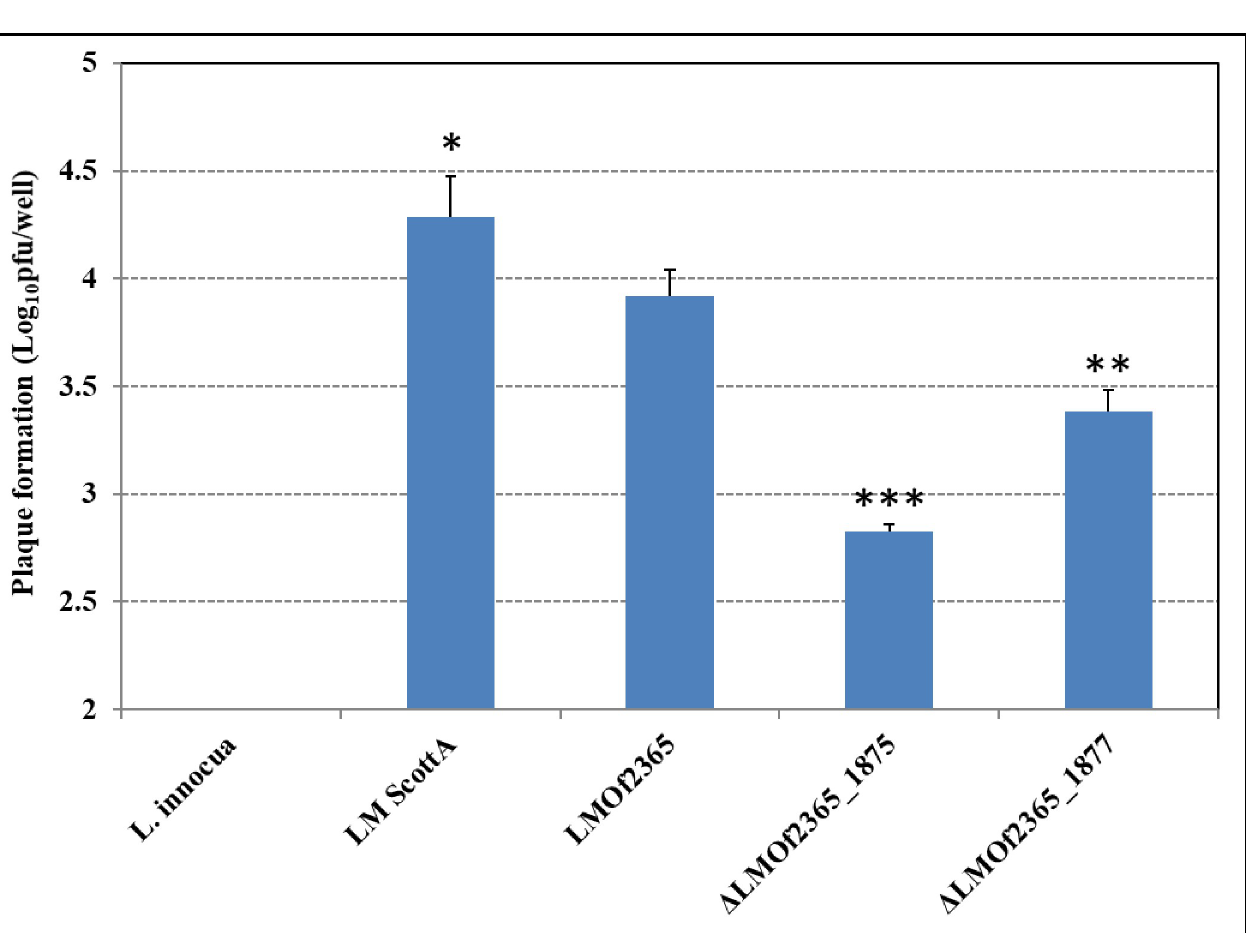
Fig 2. Plaque formation of Listeria strains in HT-29 cells. Results are presented as the log 10 numbers of plaque-forming units (pfu) per well ± standard deviation of triplicate. Significant differences from parental wild type LMOf2365 strain are shown ( � , p-value < 0.05; �� , p-value < 0.01; ��� , p-value < 0.001).